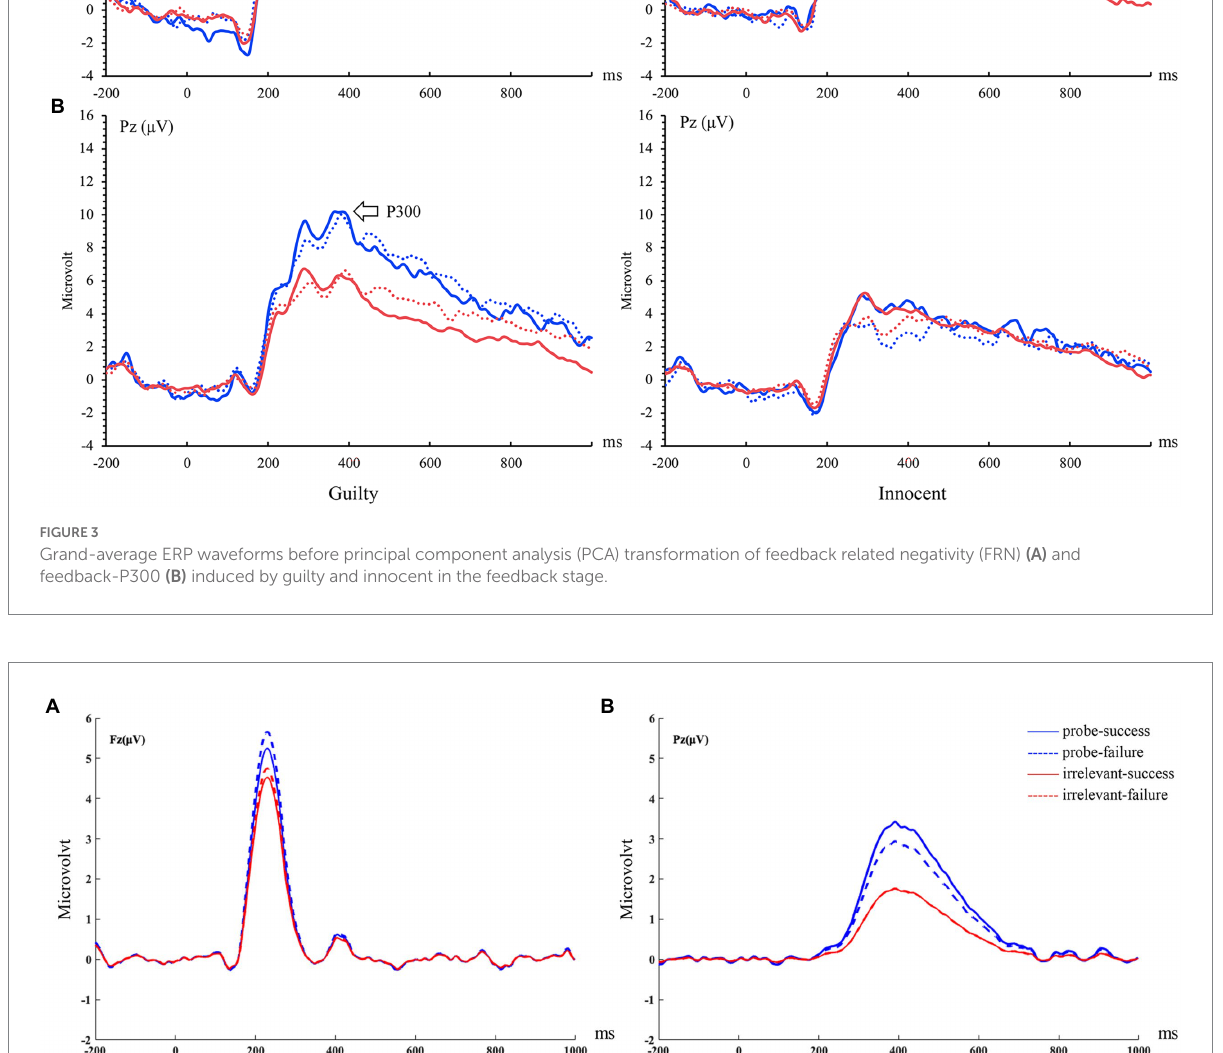
1.84 ± 0.69 μ V). The main effect of group was also significant, F (1, 50) = 7.51, p = 0.008, η p2 = 0.13, BF Inclusion = 5.02 × 10 5 , with feedback-P300 in guilty group significantly larger than that in the innocent group (4.53 ± 1.02 vs. 0.71 ± 0.95 μ V). The interaction between stimulus type and group was significant, F (1, 50) = 21.12, p < 0.001, η p2 = 0.30, BF Inclusion = 4.66 × 10 5 . Post hoc tests indicated